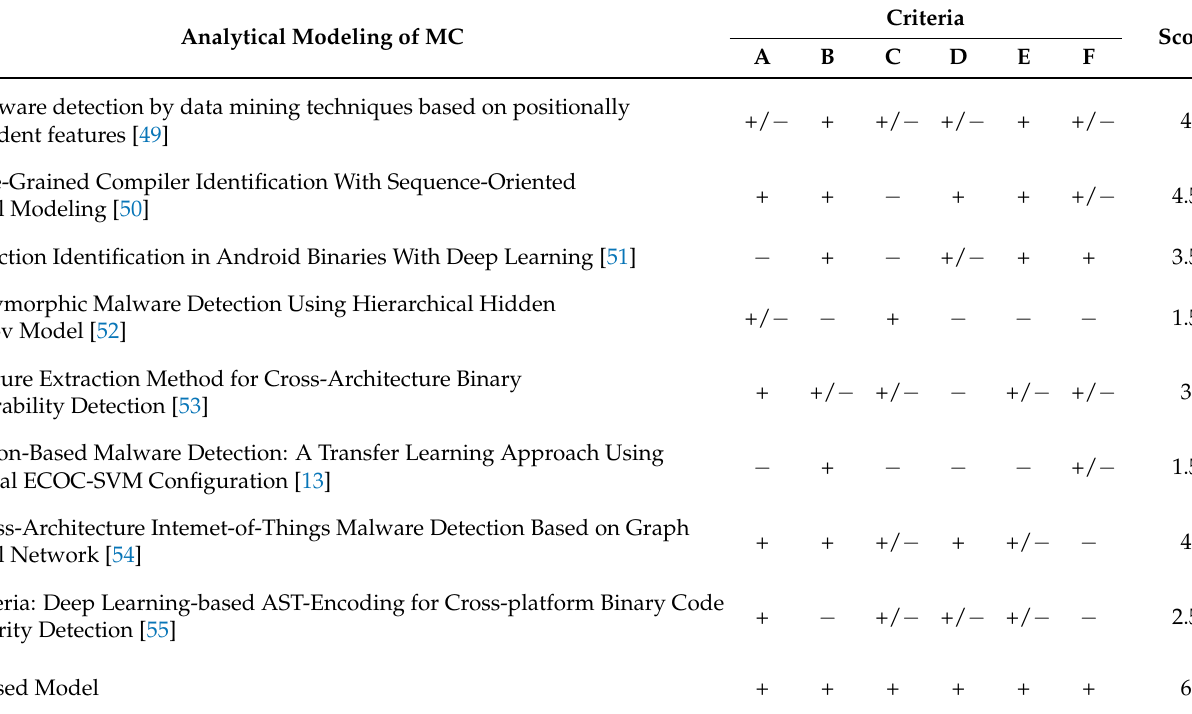
Table 2. Comparative analysis of the proposed Model with existing